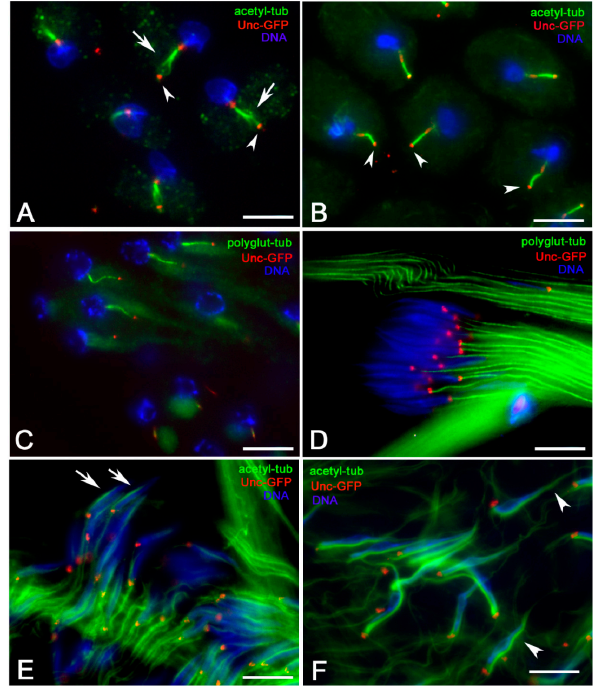
Figure 4. MT stability in elongating spermatids from testis preparations. ( A ) Nocodazole treatment: note the frayed axonemes (arrows) in correspondence of the ring centriole (arrowheads). ( B ) Cold exposure: note the continuity of the axoneme in correspondence of the ring centrioles (arrowheads). PolyglutamylatedMTsinyoung( C )andleafstage( D )spermatids: onlytheaxonemalMTsarerecognized by the antibody. Perinuclear MTs in control (arrows, ( E )) and latrunculin-treated (arrowheads, ( F )) canoe stage nuclei. Scale bars: 10 µ